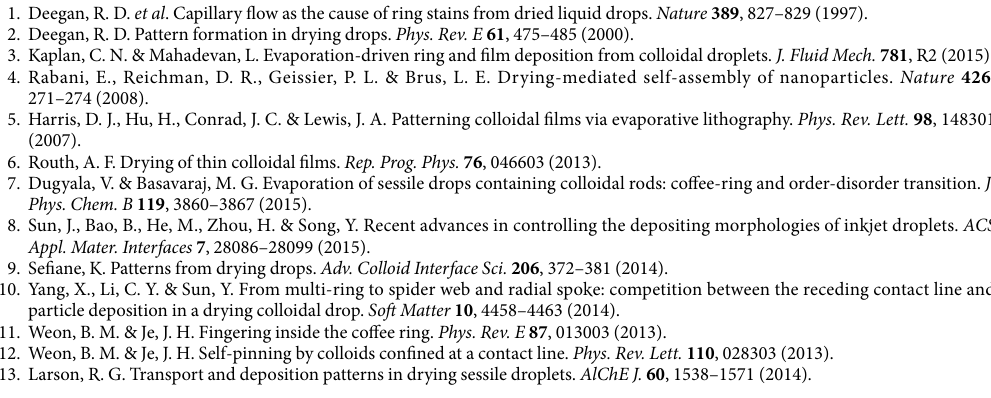
6 Scientific RepoRts | 7: 1079 | DOI:10.1038/s41598-017-00932-z